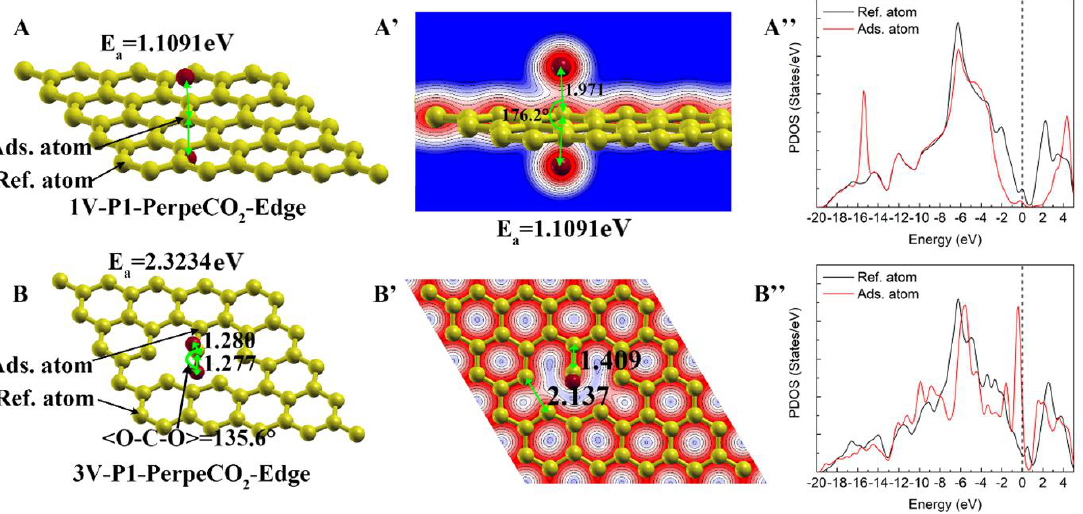
Figure 11. Energetically unfavorable chemisorption on carbon atoms with dangling bonds: ( A , A’ ) and ( B , B’ ) represent the atomic structure/charge distribution of adsorption on monovacancy (1V) and trivacancy (3V) defects, respectively. A is the result of 1V-P1-ParaalCO 2 -Edge, and B is the result of 3V-P1-ParaalCO 2 - Edge.